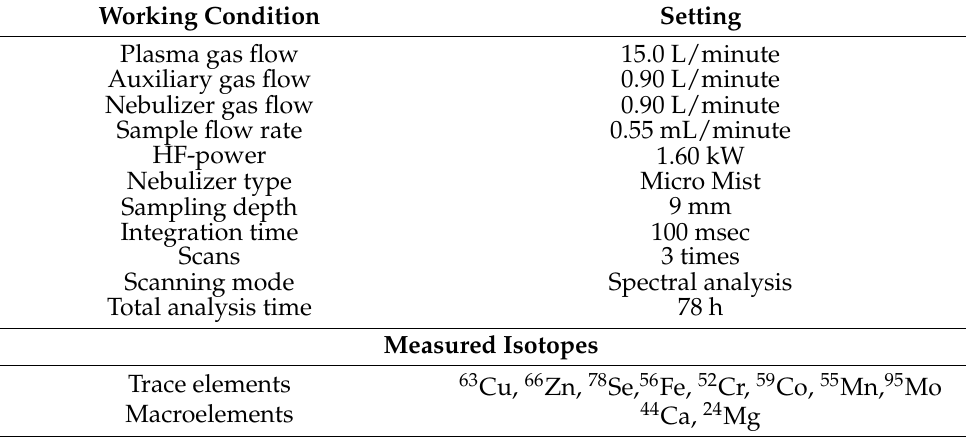
Table 4. ICP-MS setting